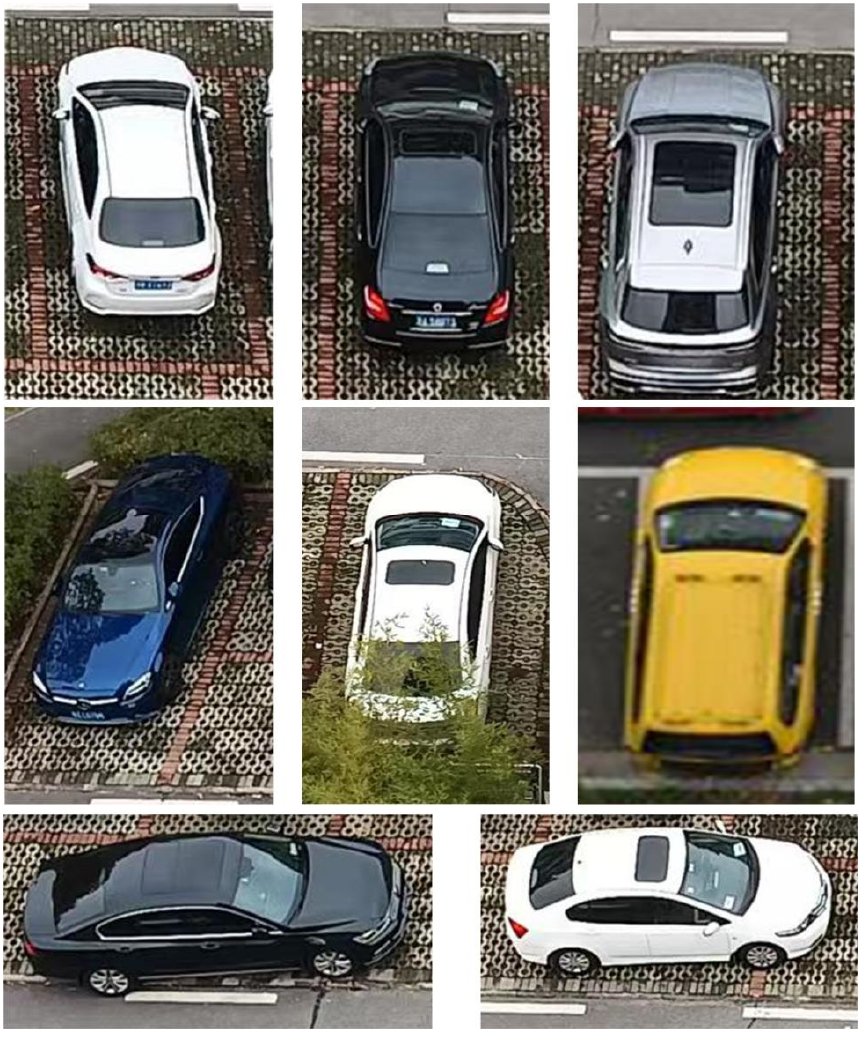
Figure 13. Partial vehicle images in the data set.